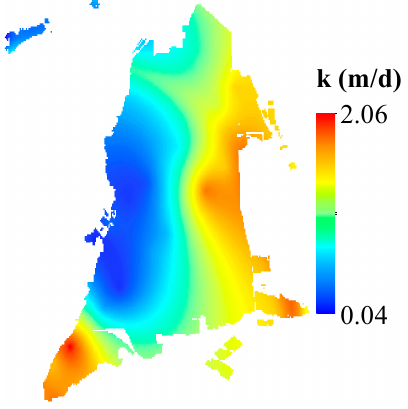
Figure 2. Spatial distribution map of hydraulic conductivities of Yaoba Oasis.